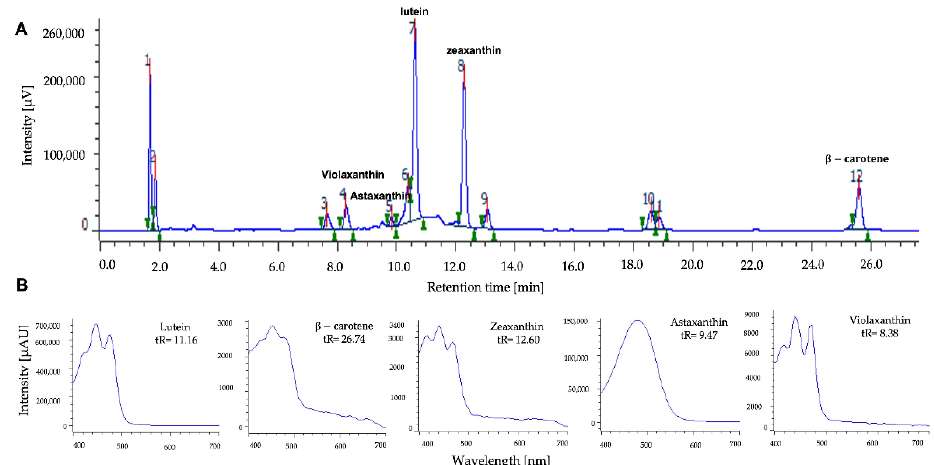
Figure 3. ( A ) Chromatogram representative of microalgal of MCH-35 analyzed using the HPLC method. ( B ) Absorption spectrum in UV-Vis and retention times of the carotenoids violaxanthin, astaxanthin, lutein, zeaxanthin and β -carotene obtained from microalgal extracts by diode array detector.